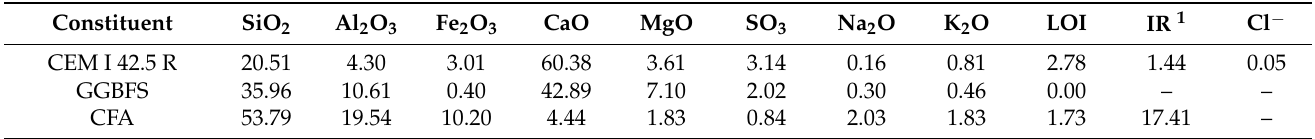
Table 3. Chemical compositions of ground granulated blast-furnace slag, GGBFS, coal siliceous fly ash, CFA, and Portland cement, CEM I 42.5 R, determined according to EN 196-2